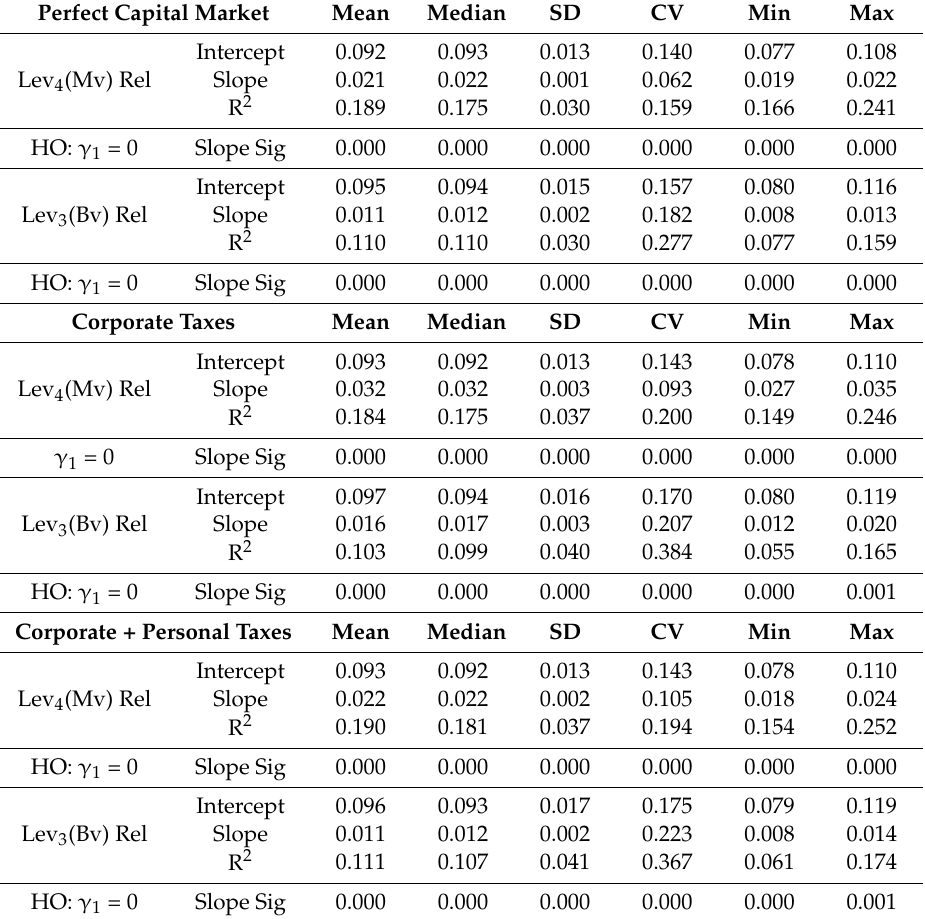
Table 2. Regression